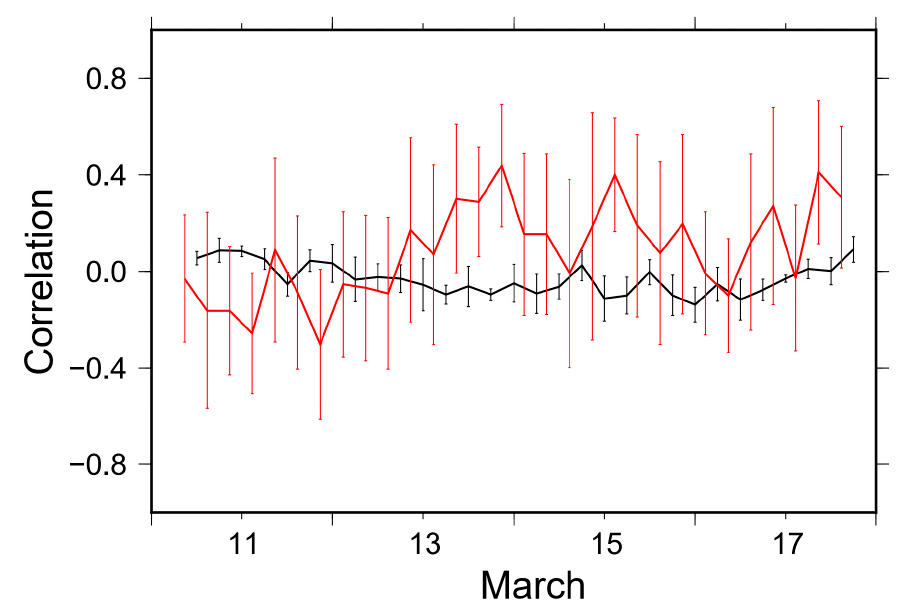
Figure 5. Correlation analysis for energy in between 0.1 and 0.5 Hz. Red: the F-K analysis results. Black: the polarization results. The error bar is the standard deviation.